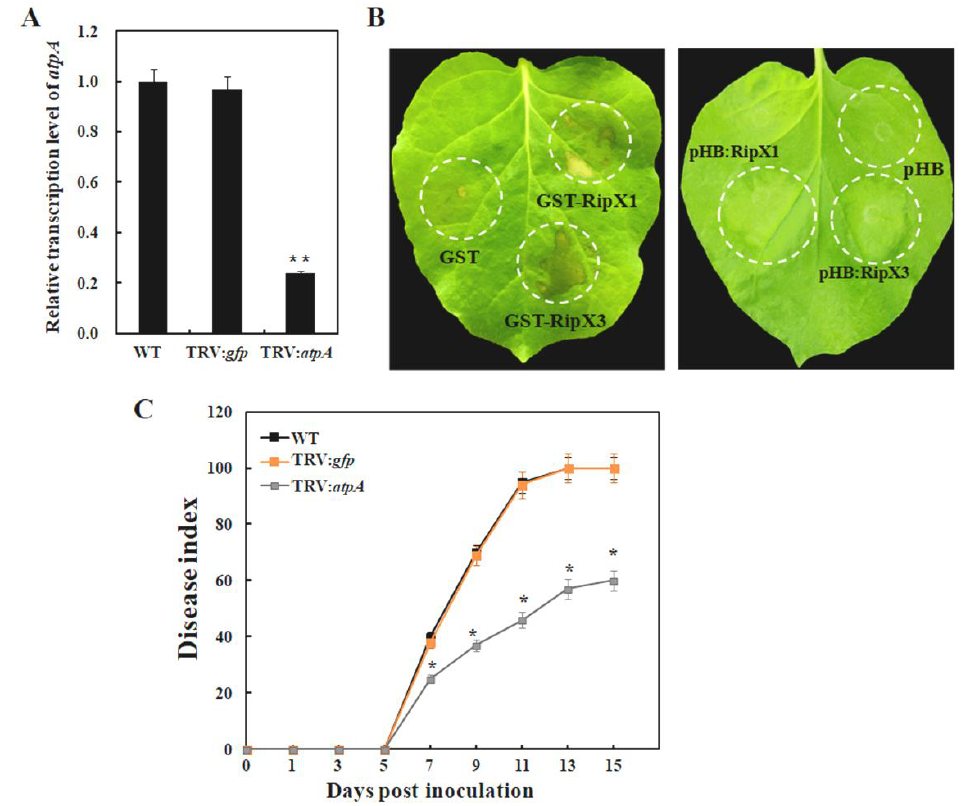
Figure 5. Involvement of the atpA gene in bacterial wilt disease. ( A ) Detection of the transcript level of atpA gene in gene-silenced plants by qRT-PCR. The transcript level in wild type was set to 1, and the level in other samples was calculated relative to that. Error bars indicate standard deviations of three individual replicates, and asterisks denote statistical significance (** p < 0.01). ( B ) Examination of the HR and yellowing phenotypes in atpA -silenced plants induced by RipX. ( C ) Disease development in atpA -silenced N. benthamiana plants. Each point represents the mean disease index of 24 plants combined from four separate experiments. Asterisks indicate the significant difference by ANOVA ( p < 0.05).